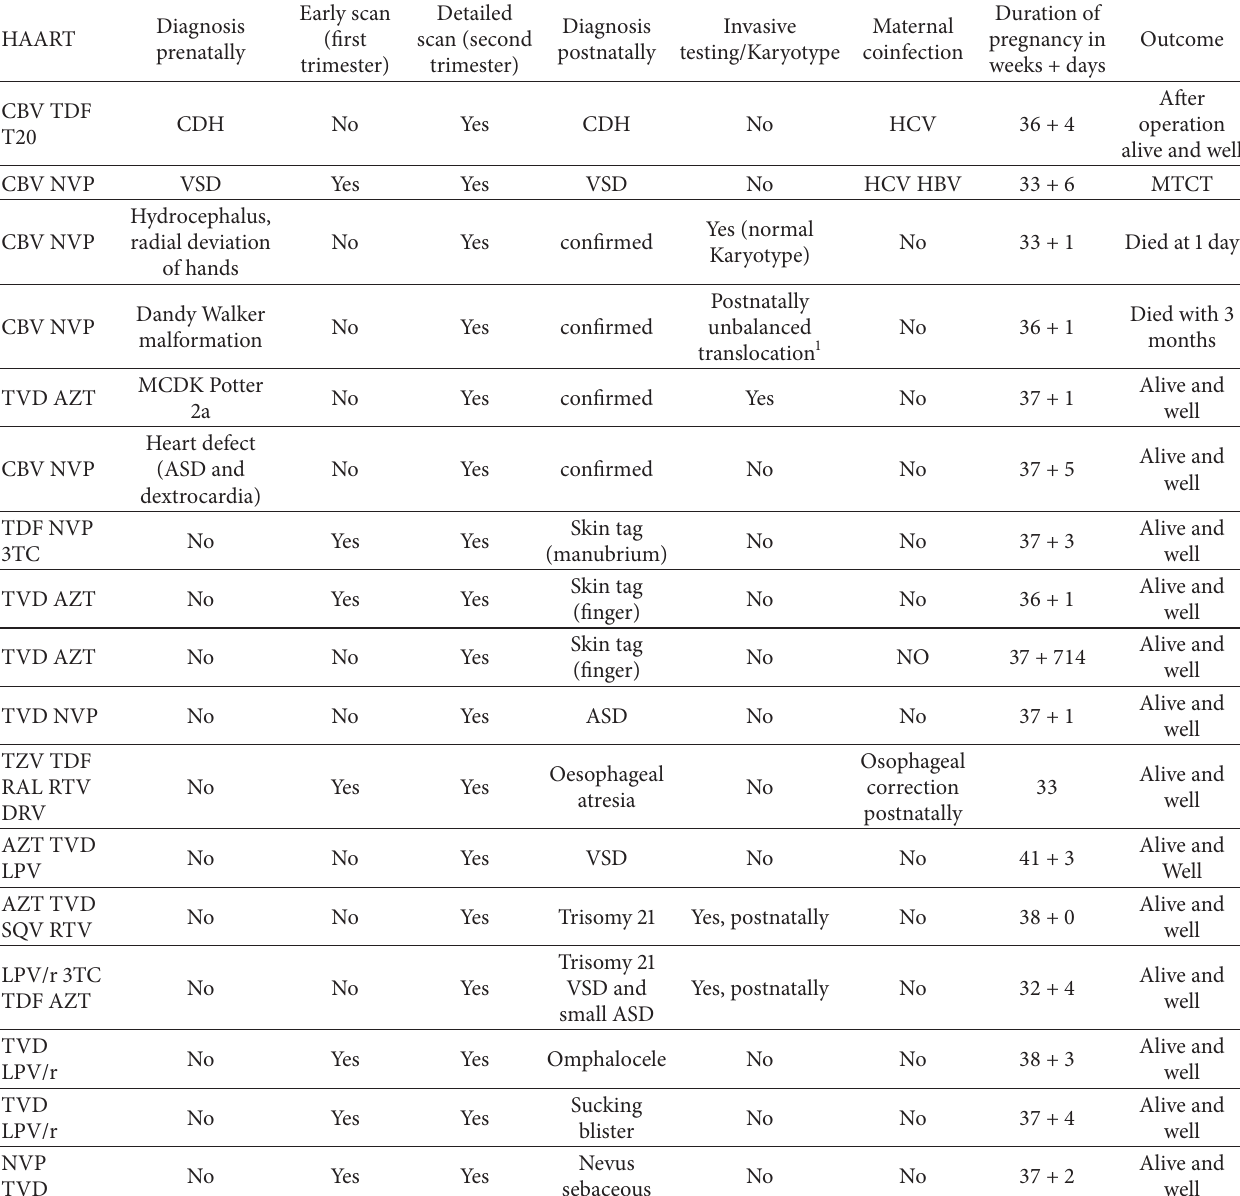
Table 4: Fetal and neonatal malformation/chromosomal anomalies.